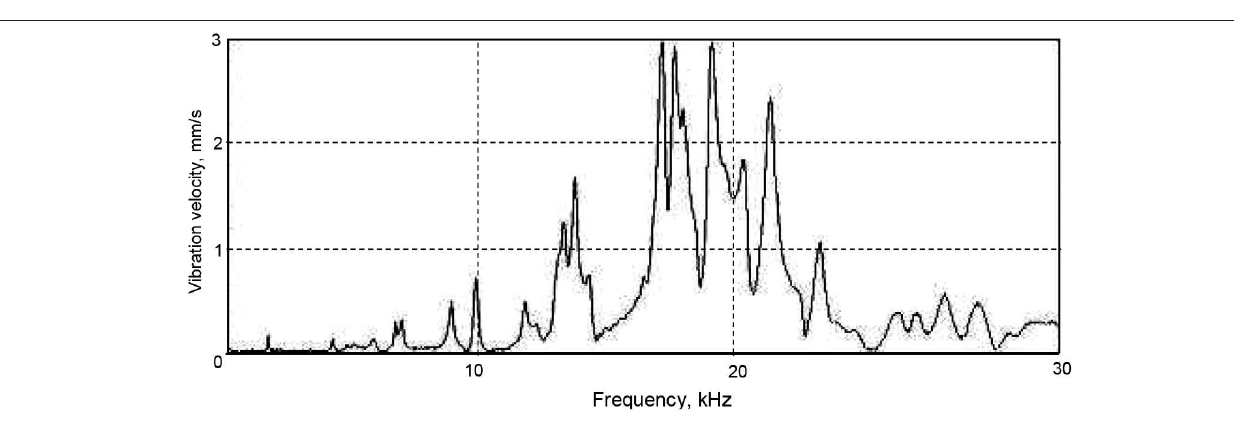
FIGURE 6 | Spectrum of fractional LDR for BVID defect in CFRP plate ( Figure 5a